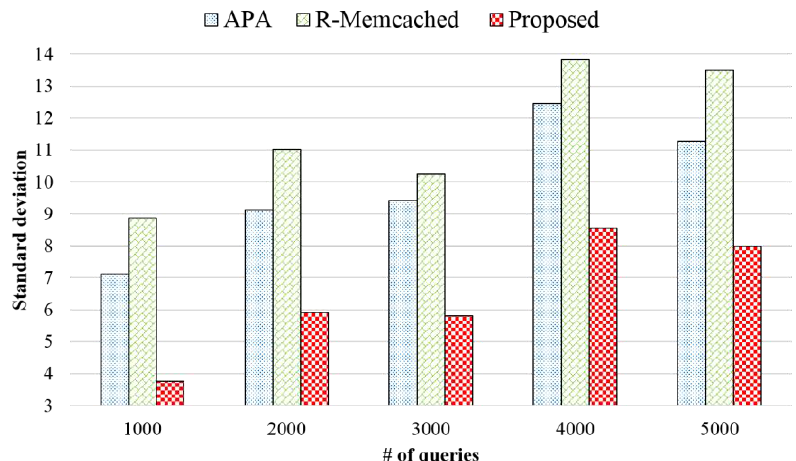
Figure 20. Standard deviation of the node access frequency according to the number of query requests.